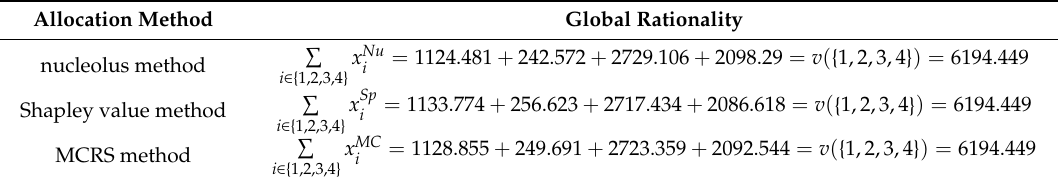
Table 5. Grand rationality analysis